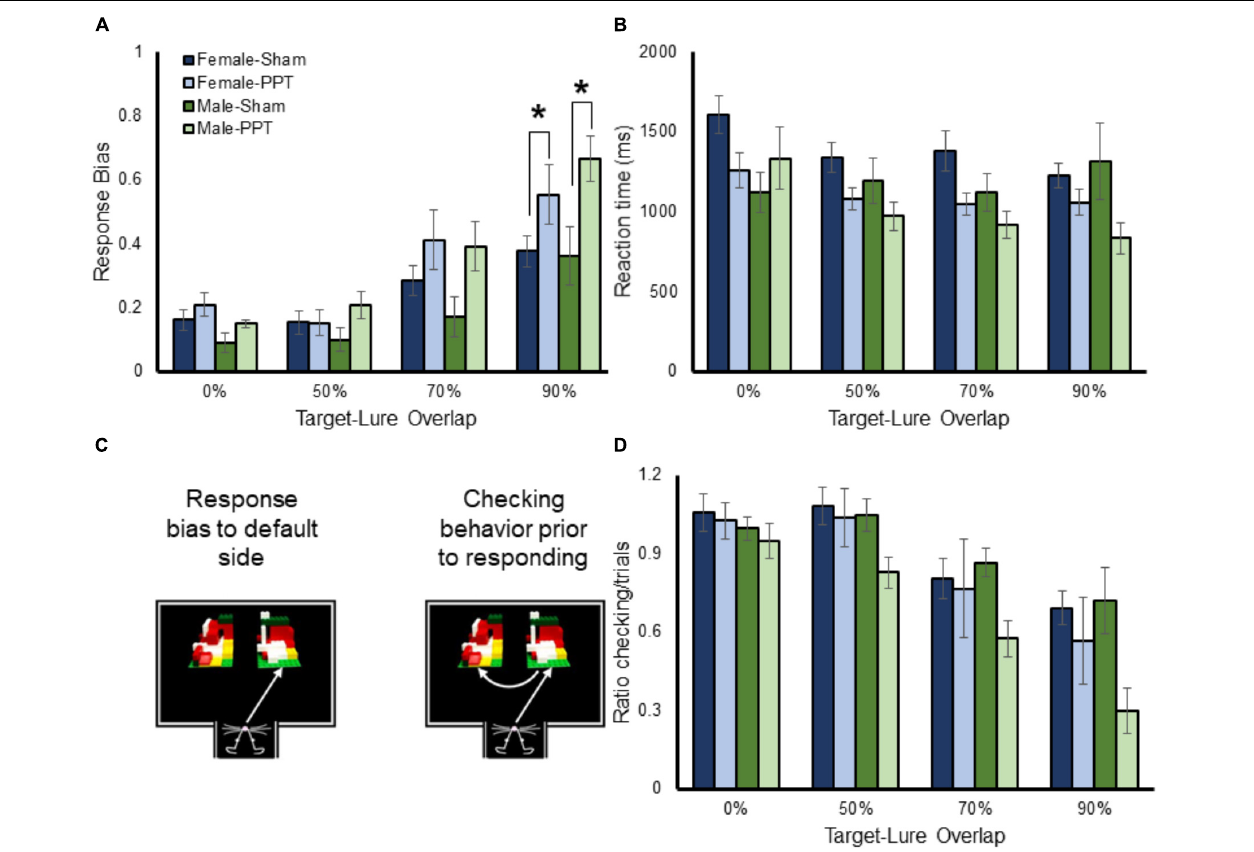
FIGURE 5 | Response bias, reaction times and checking behavior as a function of target-lure similarity. (A) shows the mean response biases ( Y -axis) for male and female Sham and PPT animals as a function of target-lure similarity ( X -axis). The response bias was higher for more similar target-lure problems ( F [ 3 , 78 ] = 40.26, p = 0.0001). The main effect on target-lure similarity on response bias did not interact with sex ( F [ 3 , 78 ] = 1.24, p = 0.301). There was, however, a significant interaction with experimental group ( F [ 3 , 78 ] = 3.40, p = 0.022), due to the PPT rats having larger response biases relative to the Sham animals as the target-lure similarity increased. (B) Shows the reaction times ( Y -axis) as a function of target-lure similarity ( X -axis). Reaction times were faster for the more similar lure conditions ( F [ 3 , 78 ] = 6.99, p = 0.001). The tendency for rats to choose an object faster when the target and lure were more similar did not significantly interact with sex ( F